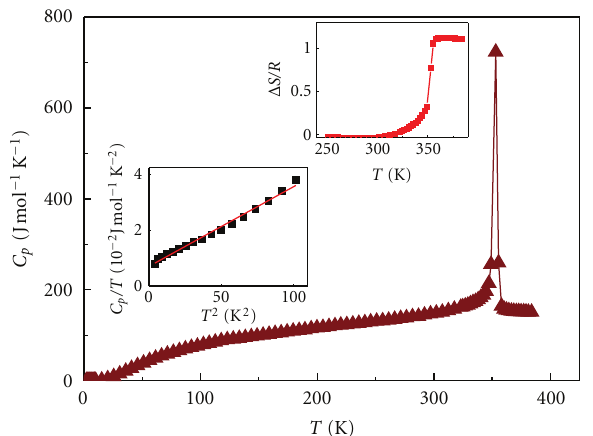
F 3: Temperature dependence of the and right insets show a linear �t to the estimation of , respectively. Δ𝑆𝑆